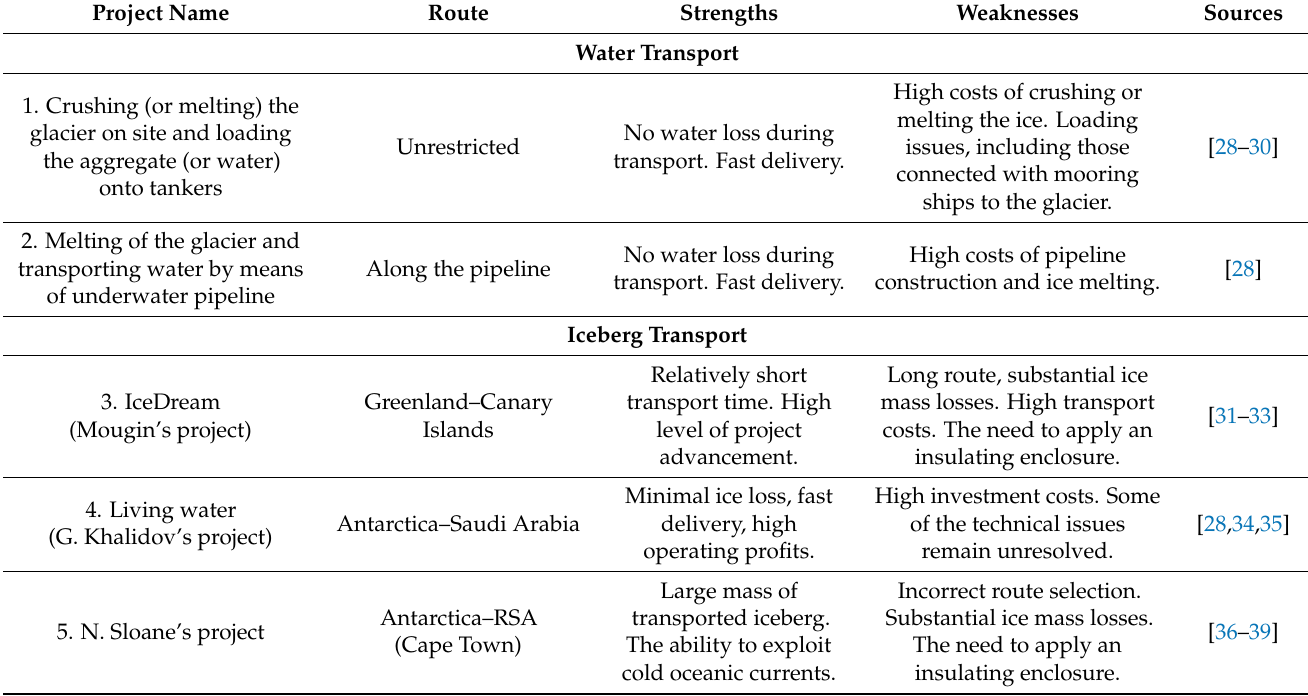
Table 1. Comparative analysis of selected projects of iceberg-sourced freshwater supply to tropical-zone countries (own elaboration based on [28–39]).